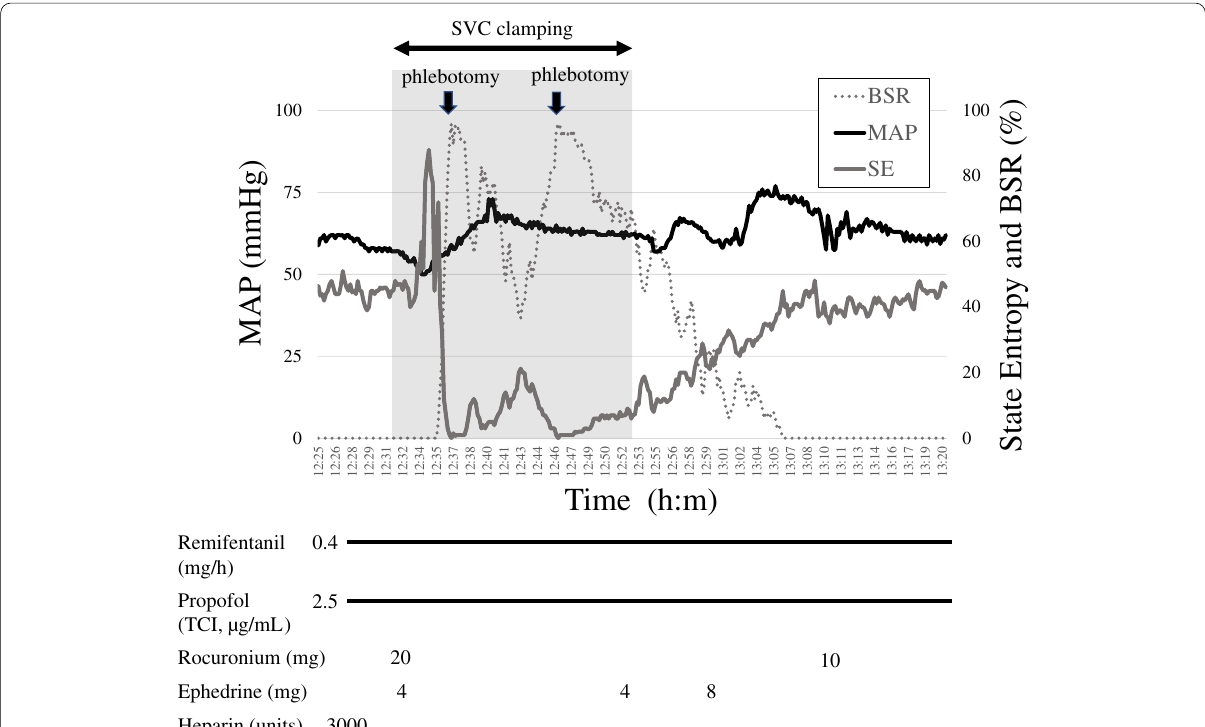
Fig. 1 Clinical course. Black line indicates mean atrial pressure (MAP). The gray line indicates the state entropy (SE). The gray dotted line indicates the burst suppression ratio (BSR). The black arrow indicates phlebotomy. During cerebral congestion, the gray area indicates superior vena cava (SVC) clamping. Increases in SE and decreases in BSR were observed two times after the phlebotomy procedures. TCI, target-controlled